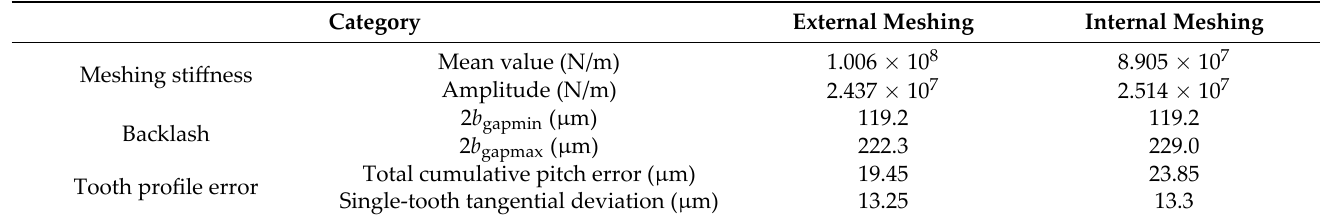
Table 4. Excitation parameters.